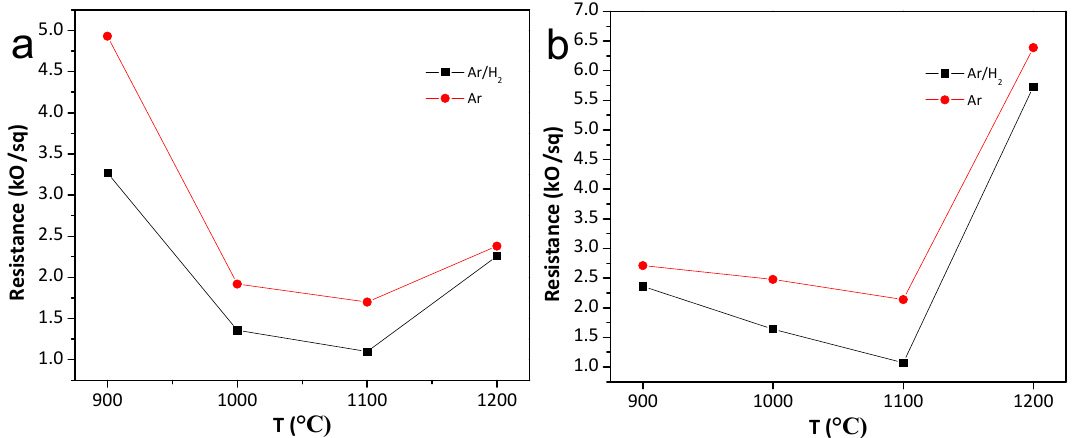
Figure 6. Plots of the electrical resistance for (N)G ( a ) and G ( b ) films on quartz substrate prepared at different pyrolysis temperatures under Ar or Ar/H 2 (5%) flow.